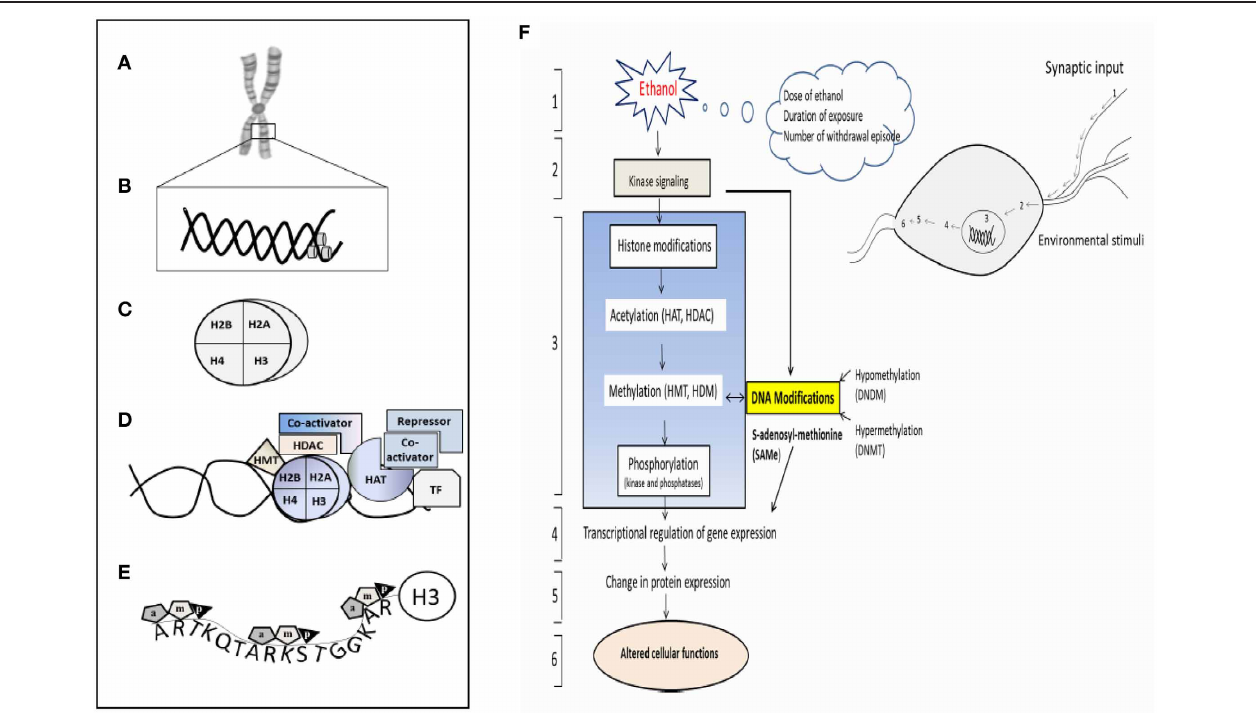
genes and proteins. (1) Ethanol exposure of nerve cells (environmental stimuli), (2) these external stimuli result in changes in downstream genes and kinase signaling pathway. (3) Histone Modification (Acetylation, methylation and phosphorylation) and their responsible enzymes. (4) Transcriptional regulation and gene expression, (5) translation (protein expression), (6) altered cellular function. HAT- histrone acetyl transferase; HDAC- histone deacetylase; HDM-histone demethylase; HMT-histone methyl transferase. The model was adapted and modified from Shukla et al.